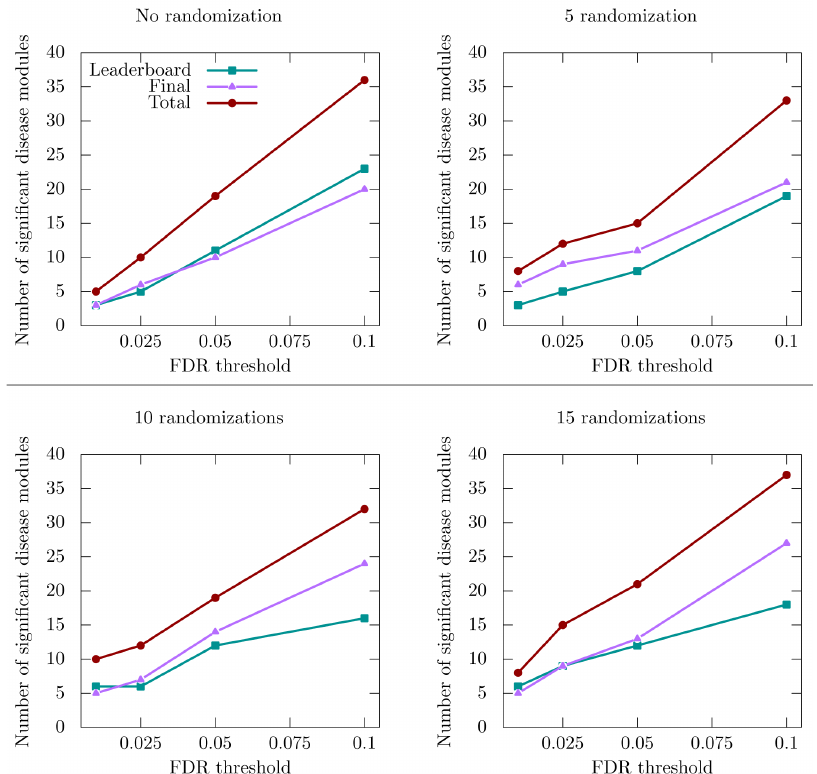
Figure 2. Number of significant disease modules identified from the multiplex network for different GWAS datasets and FDR thresholds. “Leaderboard” and “Final” datasets were used during the training and final evaluation of the challenge, respectively, whereas the “Total” dataset is the union of the two previous ones. The total number of considered communities is 605 in the absence of randomization, 584 for 5 randomizations, 585 for 10 randomizations and 582 for 15 randomizations.